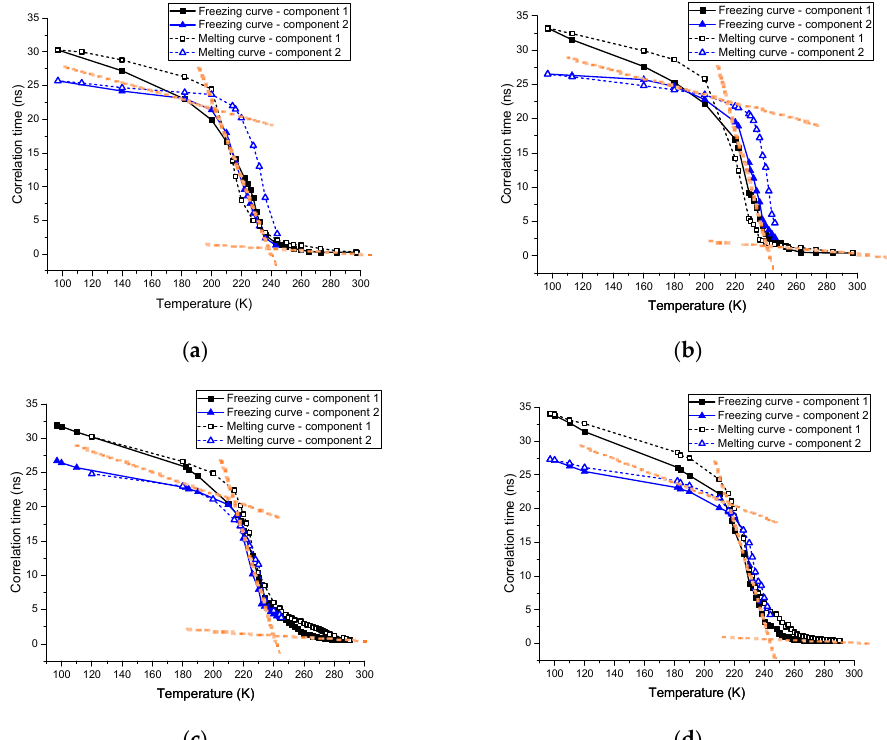
Figure 5. ( a ) Curves of correlation times ( τ c ) of the 2.0 mg/mL spin labeled L23C in the 5% glycerol solution versus temperature through the freezing process, and melting process; (see the inset in the Figure.); ( b ) those of the 2.0 mg/mL spin labeled L23C in the 5% propylene glycol solution; ( c ) those of the 2.0 mg/mL spin labeled A17C in the 5% glycerol solution; and ( d ) those of the 2.0 mg/mL spin labeled A17C in the 5% propylene glycol solution.